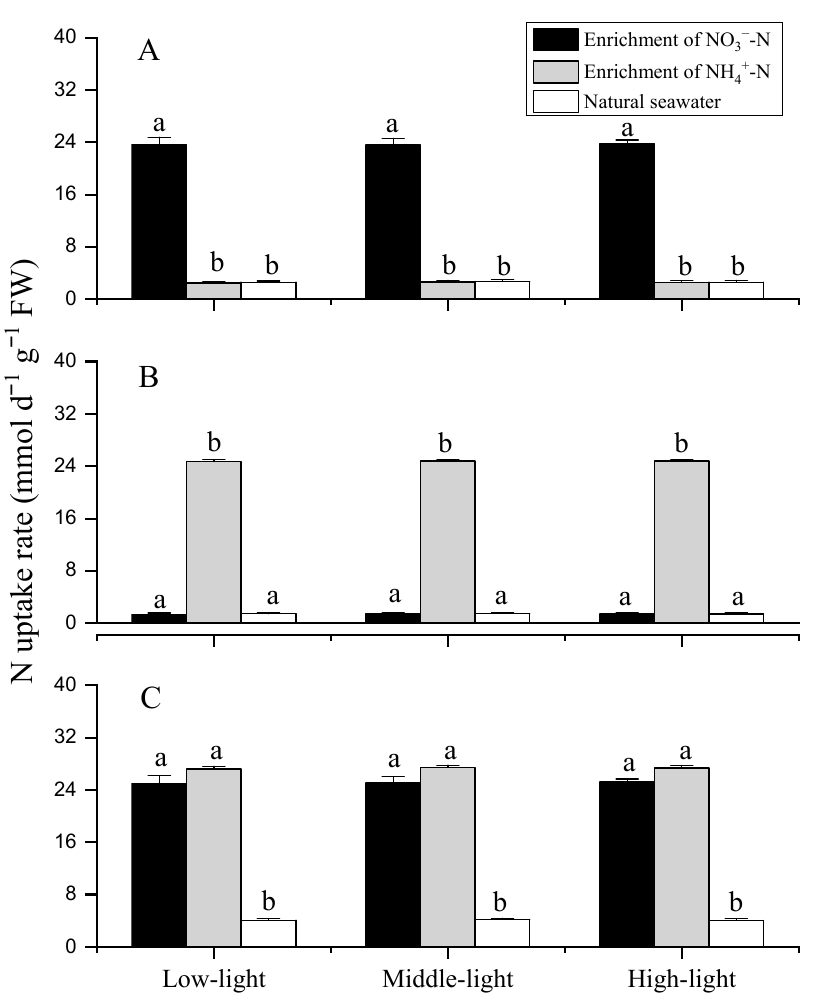
Figure 5. N uptake rate of S. horneri after being grown at different light and N conditions for 10 days ( A , NO 3 − − N; B , NH 4+ − N; C , Total N). Data are reported as means ± SD (n = 3). Different letters above the error bars indicate significant differences between treatments ( P <